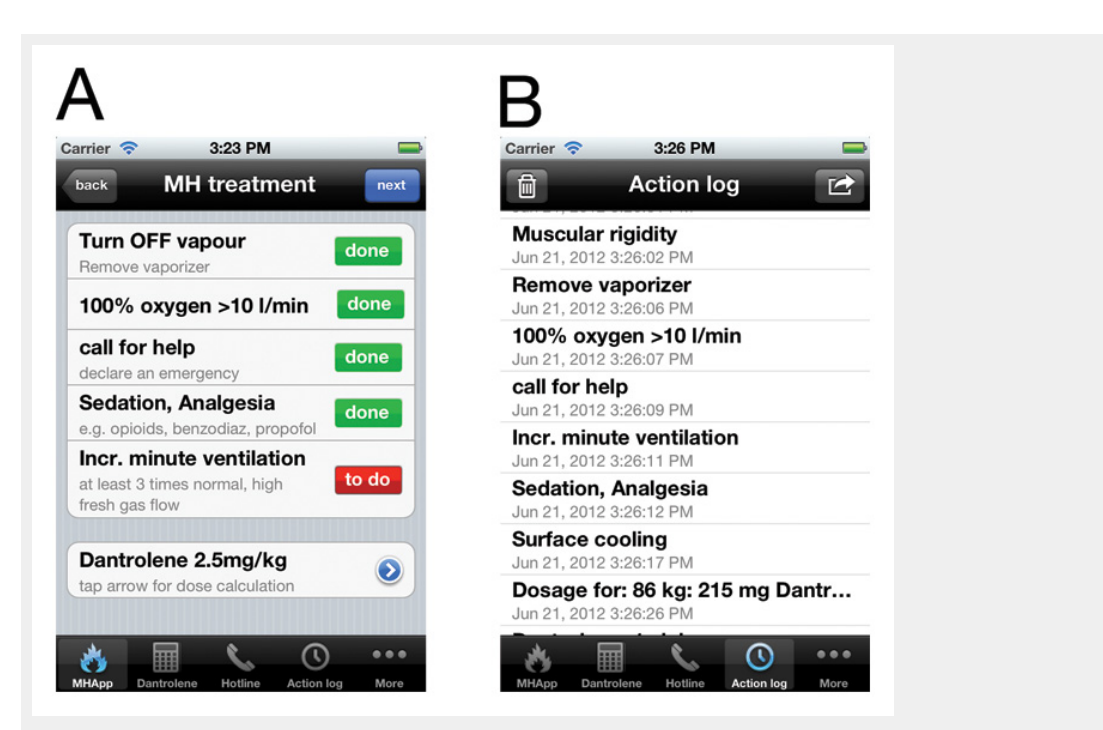
Two screenshots of the MHApp. Panel A shows the first five treatment steps, which all have to be confirmed before proceeding. Panel B shows the automatically generated protocol. This protocol can be forwarded by